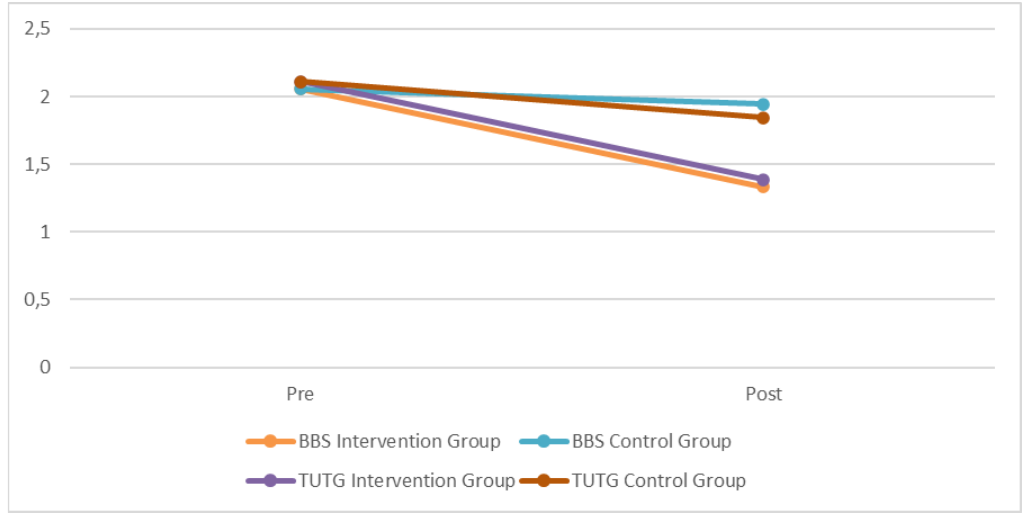
Figure 2. Mean of BBS and TUTG scores in the intervention group and the control